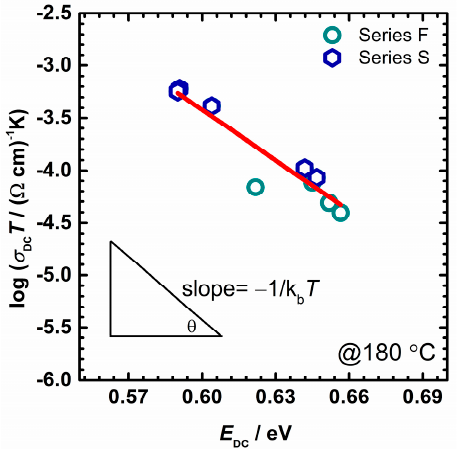
Figure 2. Effect of activation energy, E DC , on DC conductivity, σ DC T , for studied F– and S–glass series. Each point represents an individual sample. The solid line represents the least-squares linear fit to experimental data. The error bars are, at most, of the order of the symbol size.